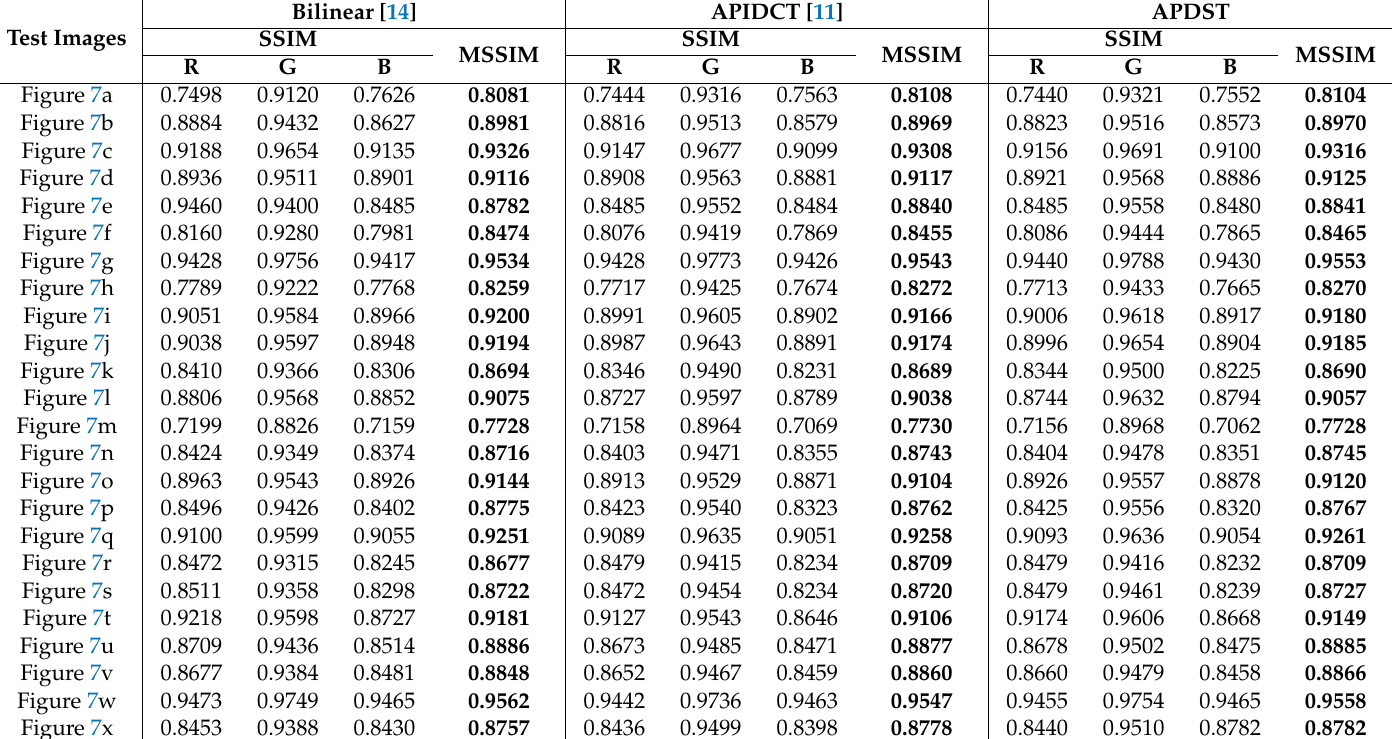
Table 2. Comparisons of SSIM and MSSIM among bilinear interpolation [14], APIDCT interpolation [11], and APDST interpolation of Kodak images with a size of 512 × 768 or 768 × 512 in PNG